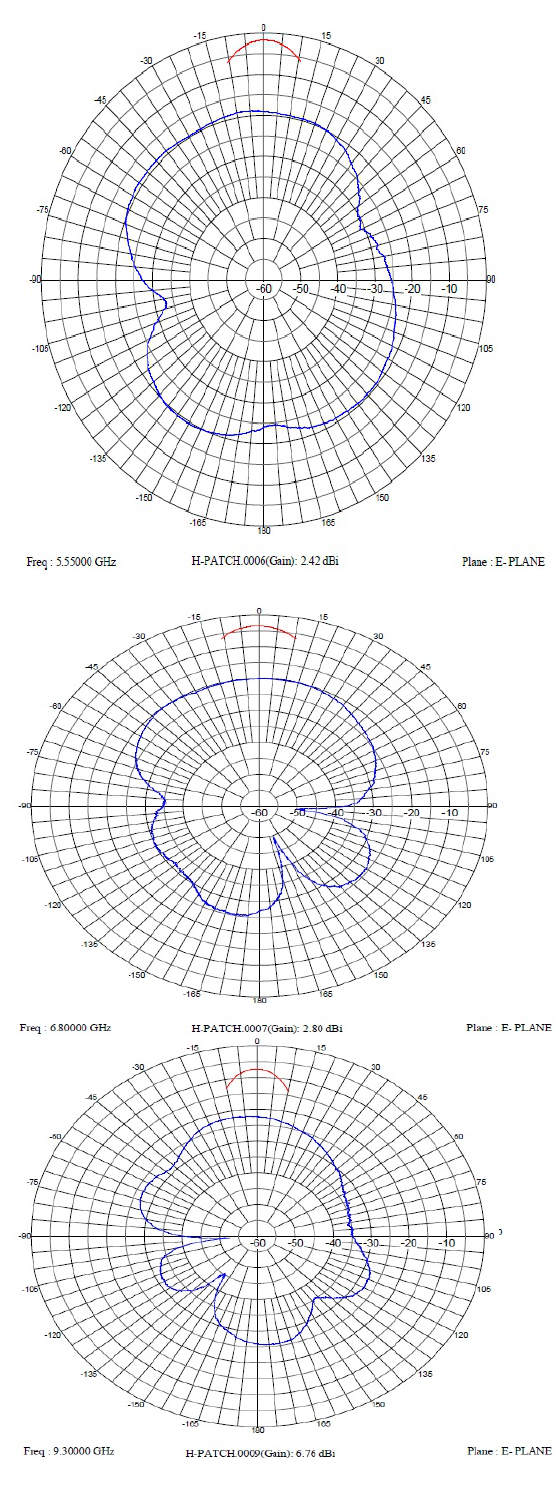
Figure 8: E plane of experimentally measured proposed antenna at frequencies 5.5GHz, 6.81GHz,